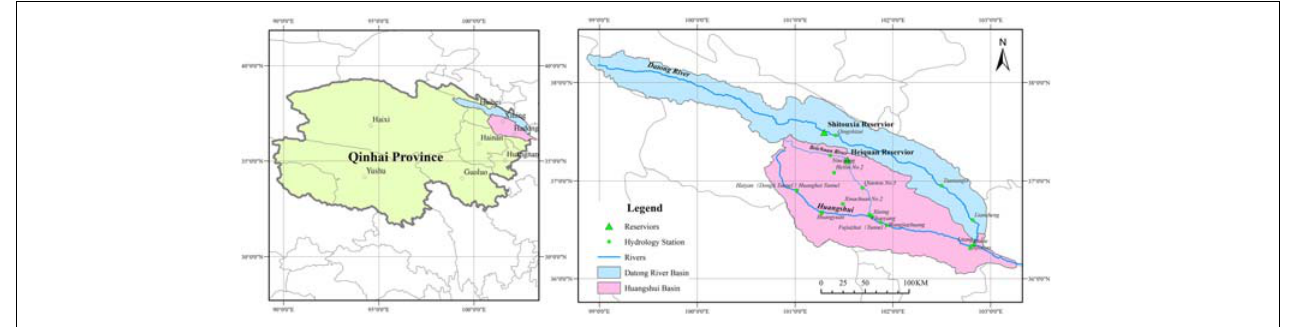
FIGURE 1 | The location of research area.